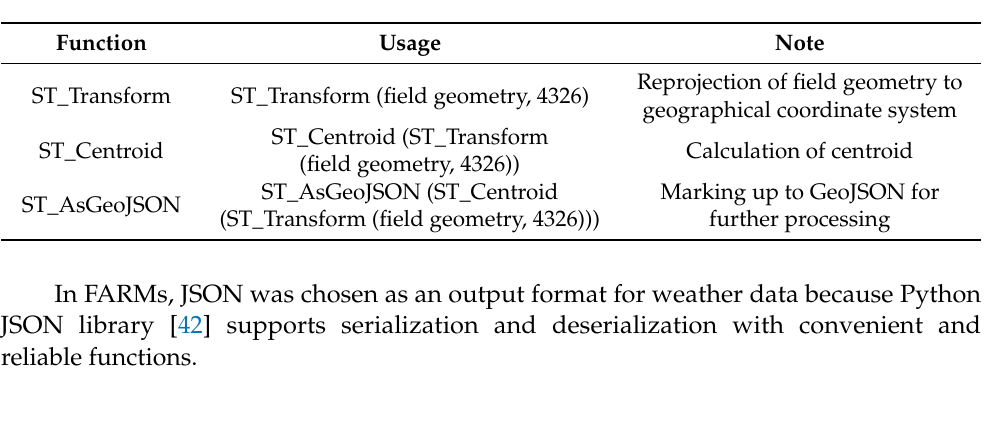
Table 2. PostGIS functions used for field centroid information